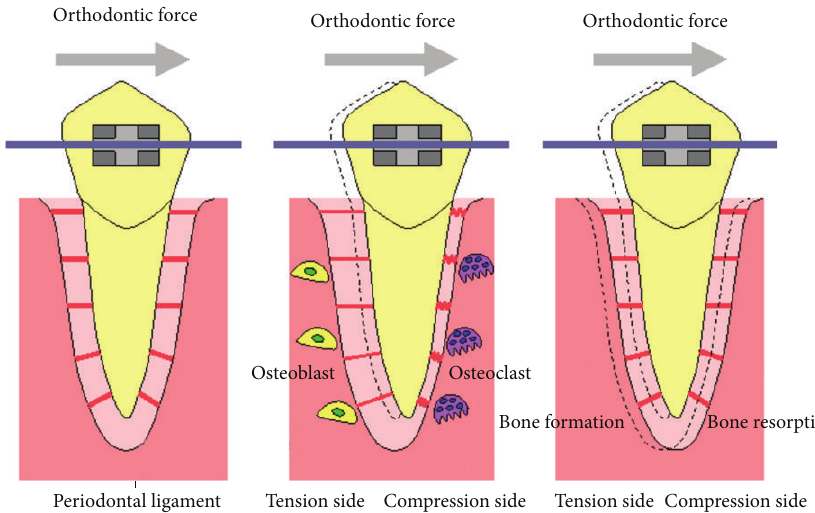
Figure 2: Schematic diagram of tooth movement. Applying orthodontic force to the tooth causes compression of the periodontal ligament. The compressed side of periodontal ligament is called the compression side and the side where the periodontal ligament is pulled is called the tension side. Osteoclasts appear on the compression side and osteoblasts on the tension side. The tooth moves as osteoclasts resorb bone while osteoblasts form